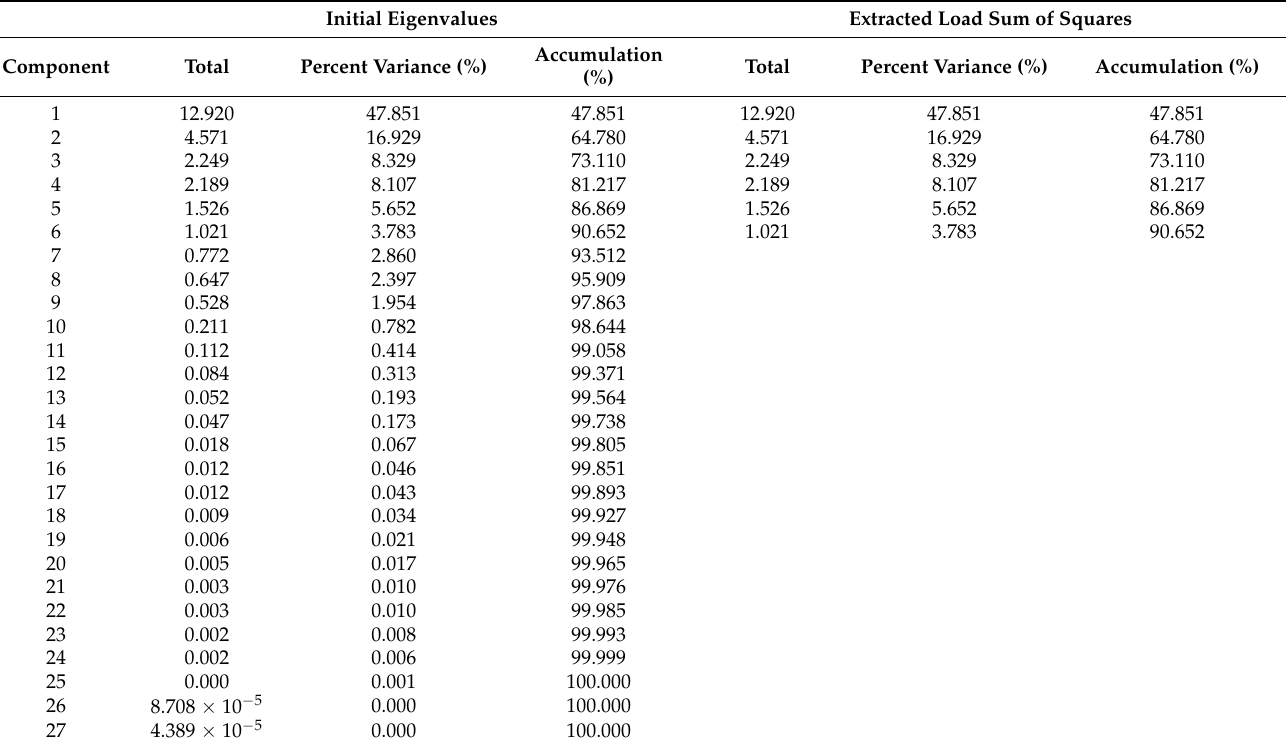
Table 7. Total explained variance of the simulated driving test data.